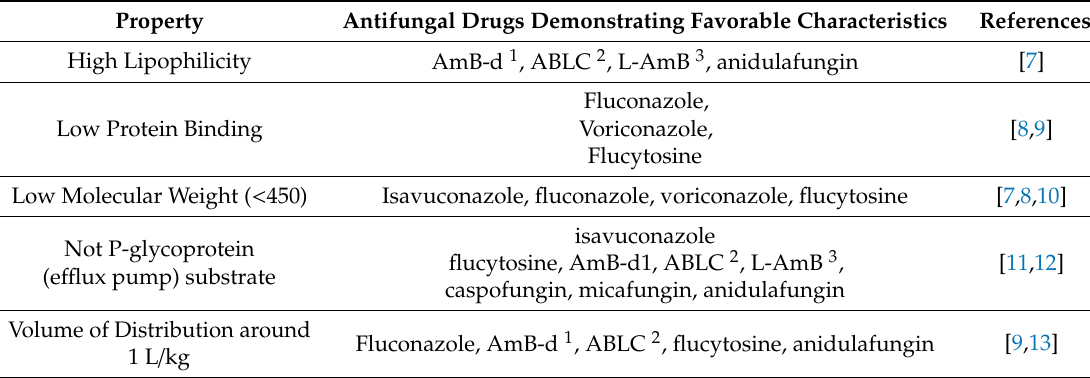
Table 1. Select properties associated with maximal CNS exposure